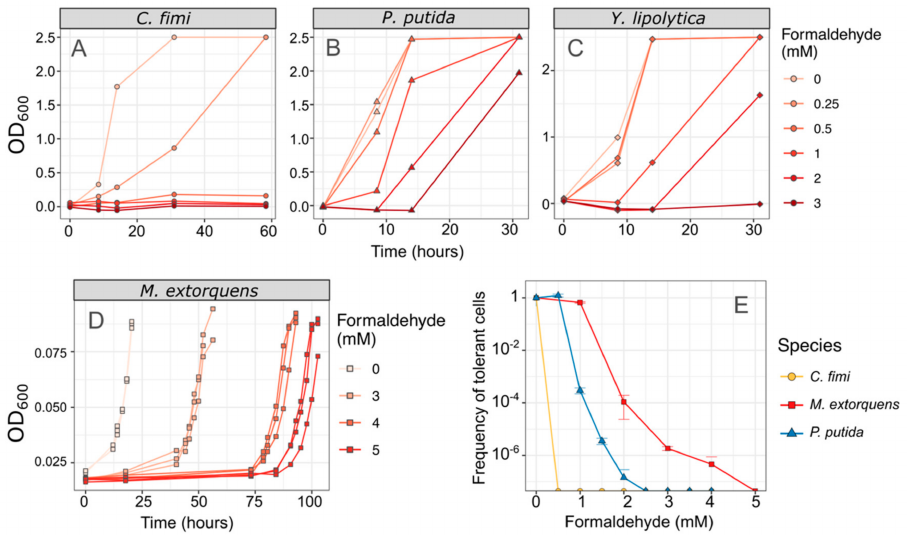
Figure 3. C. fimi is the most formaldehyde-sensitive member of the consortium. ( A – D ) Each species was grown in pure culture in minimal medium with varying concentrations of formaldehyde, and growth monitored by OD 600 . No growth was observed in C. fimi at concentrations of 0.5 mM or higher, whereas Y. lipolytica grew at up to 2 mM formaldehyde and P. putida at up to 3 mM within 30 h. Note that OD is shown here on a linear scale for ease of interpretability; note also that the color scale for formaldehyde concentrations is different between panels ( A – C ) and panel ( D ). Data from panel ( D ) are reproduced from [43]. ( E ) An alternative method of understanding formaldehyde tolerance is the enumeration of cells that are able to form colonies on agar medium containing formaldehyde. In M. extorquens , 100% of the plated population formed colonies at 1 mM and 1/10,000 formed colonies at 2 mM. P. putida cells also formed colonies at those concentrations but at a lower frequency. In C. fimi , no colonies were observed at 0.5 mM formaldehyde or higher. Error bars show the standard deviation of three replicate